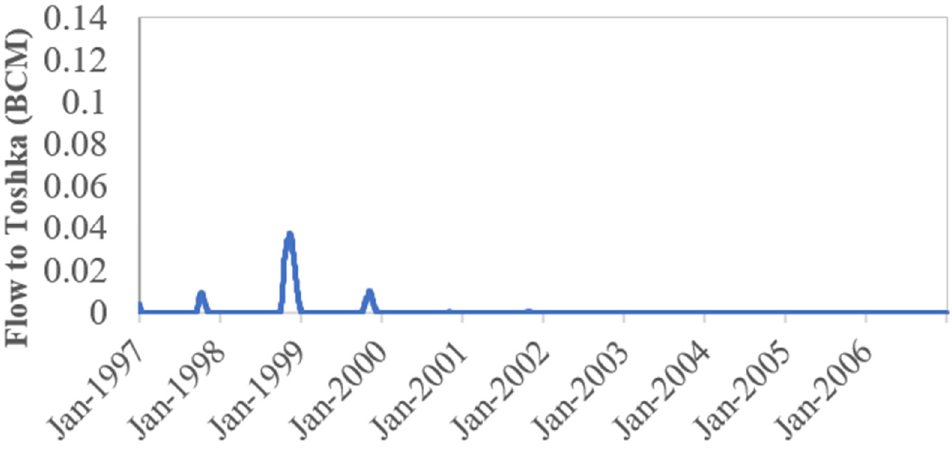
Figure 15. Toshka Spillway flow in the base scenario.